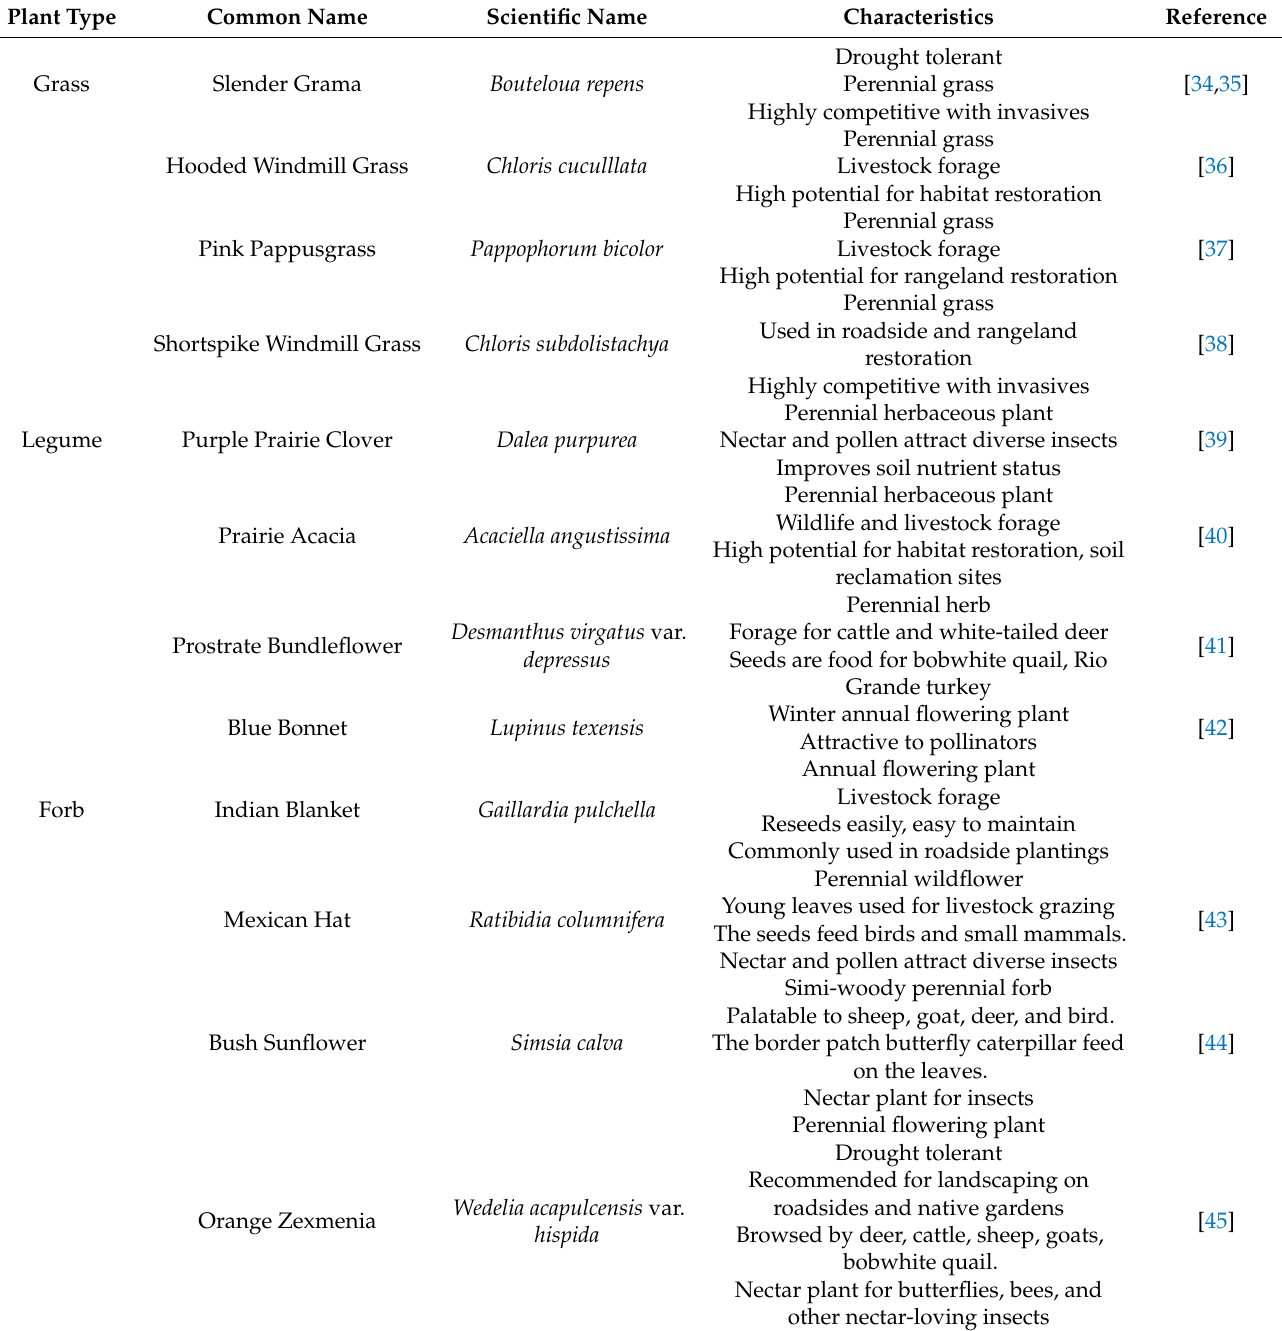
Table 2. Description of study species including scientific, and common names, plant type, characteristics supporting species selection, seed source, seeding and previously reported germination rates and their